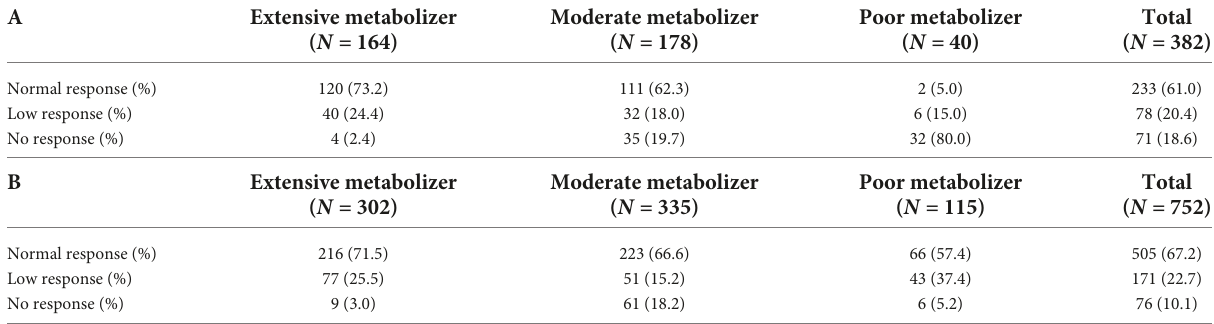
TABLE 2 Analysis of metabolic type of CYP2C19 in traditional dual antiplatelet therapy (DAPT) group (A) and individual DAPT group